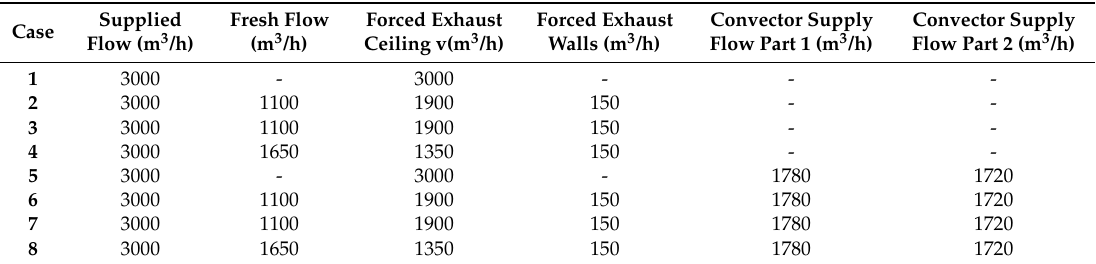
Table 3. Air flow conditions for each part of the